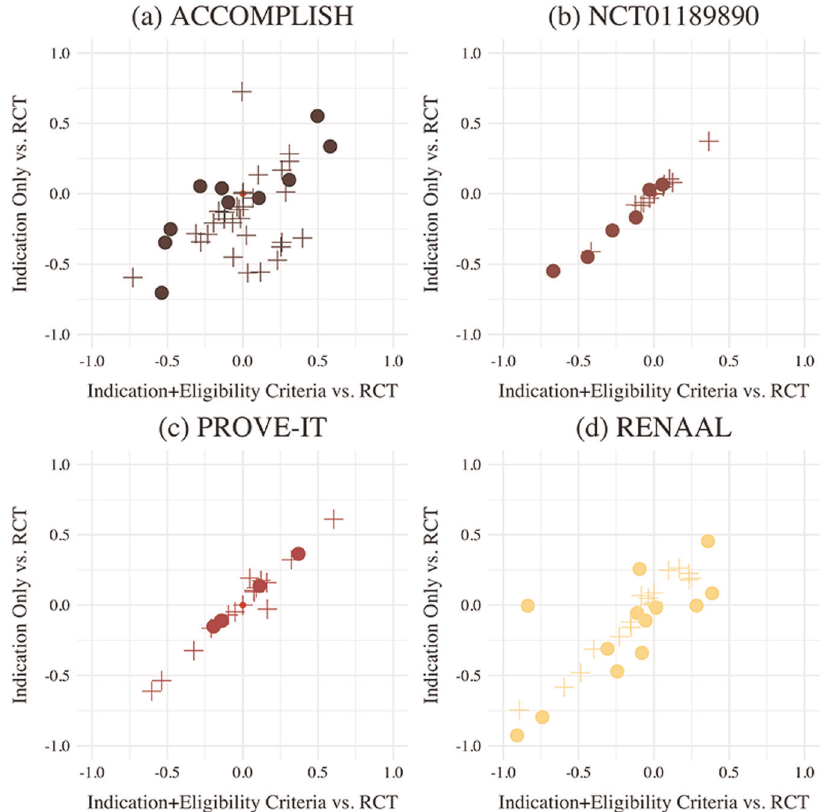
Fig. 1 Summary of Δ RCT for baseline characteristics of Indication Only vs RCT and Δ RCT Indication + Eligibilty Criteria vs. RCT. a ACCOMPLISH trial b NCT01189890 trial (sitagliptin vs. glimepiride), c PROVE-IT trial d RENAAL trial. The shape of the marker corresponds to the data type. Circles ( ● ) denote the standardized difference in the mean of continuous data. Pluses ( + ) denote the difference in percentage points of discrete